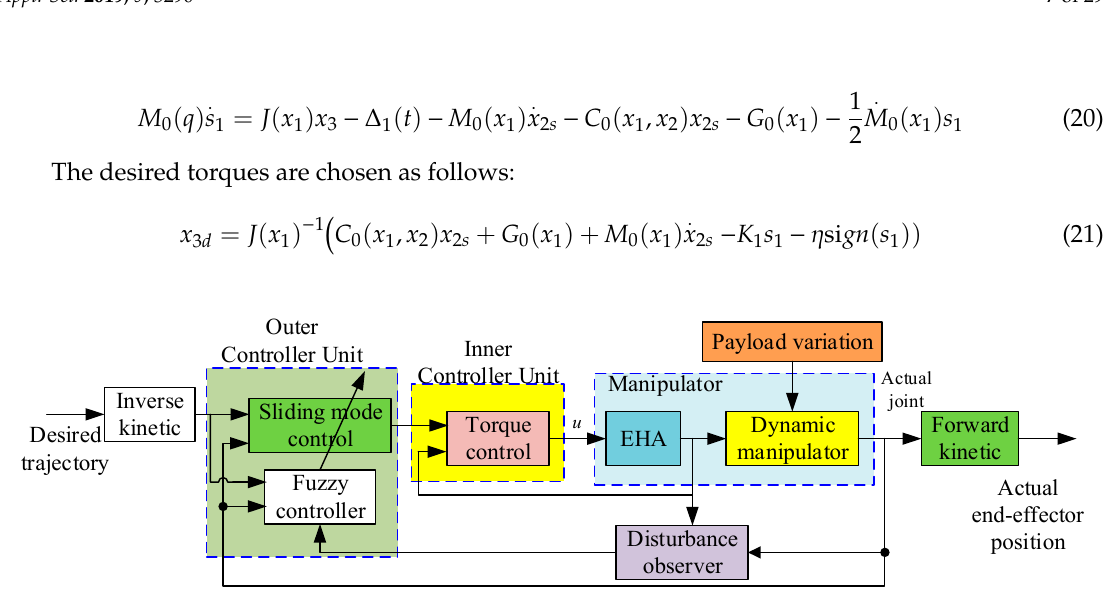
Figure 4. The block diagram of the adaptive fuzzy sliding mode control.